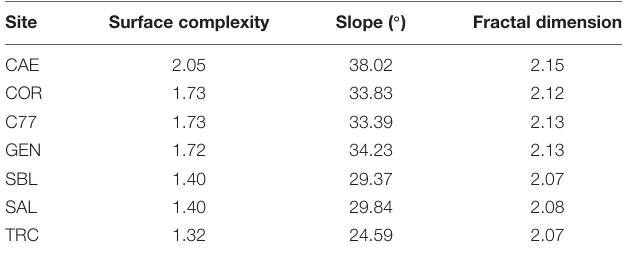
TABLE 2 | Physical descriptors of the structural complexity: surface complexity, slope, and fractal dimension computed from each study site’s DEM.